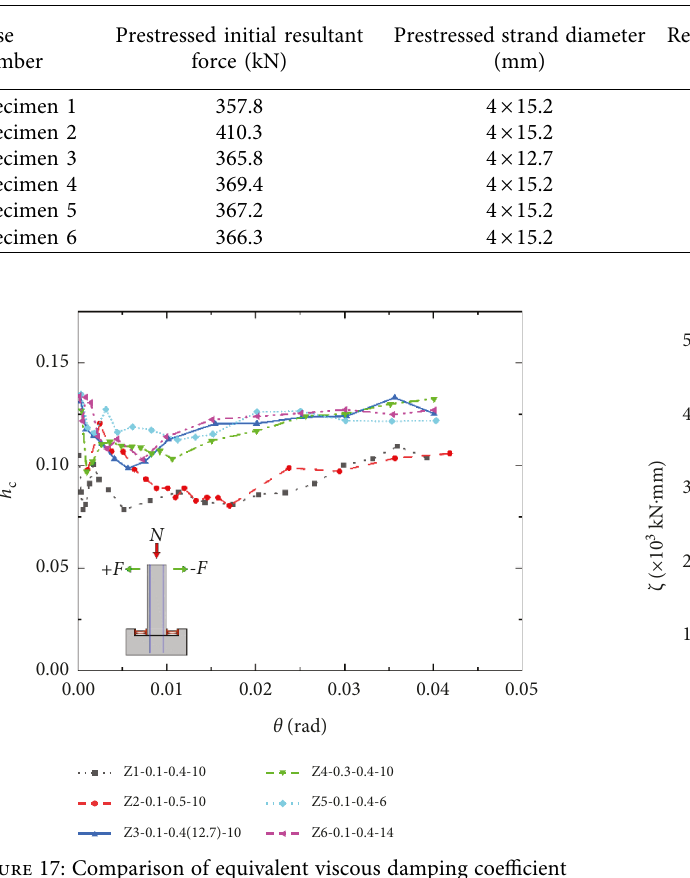
18: Comparison of cumulative energy dissipation coeffi- cient ζ